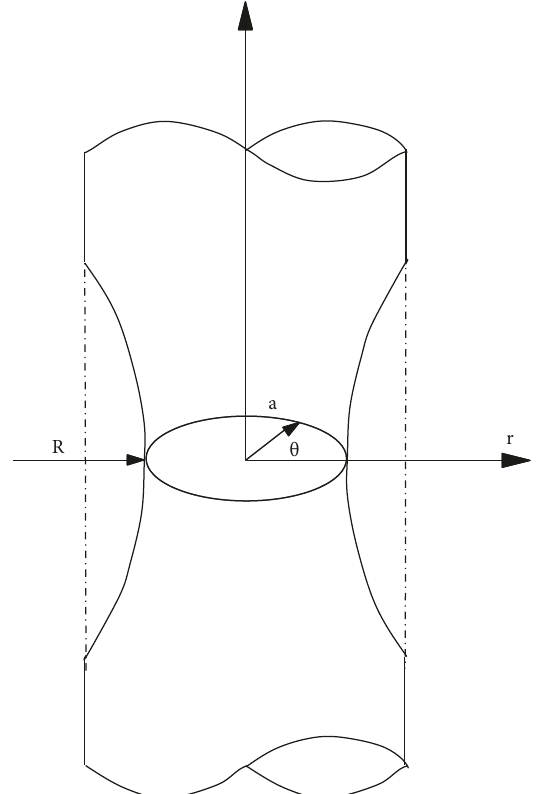
Figure 1: Diagram of the main dimensions at the neck of a Bridgman tension